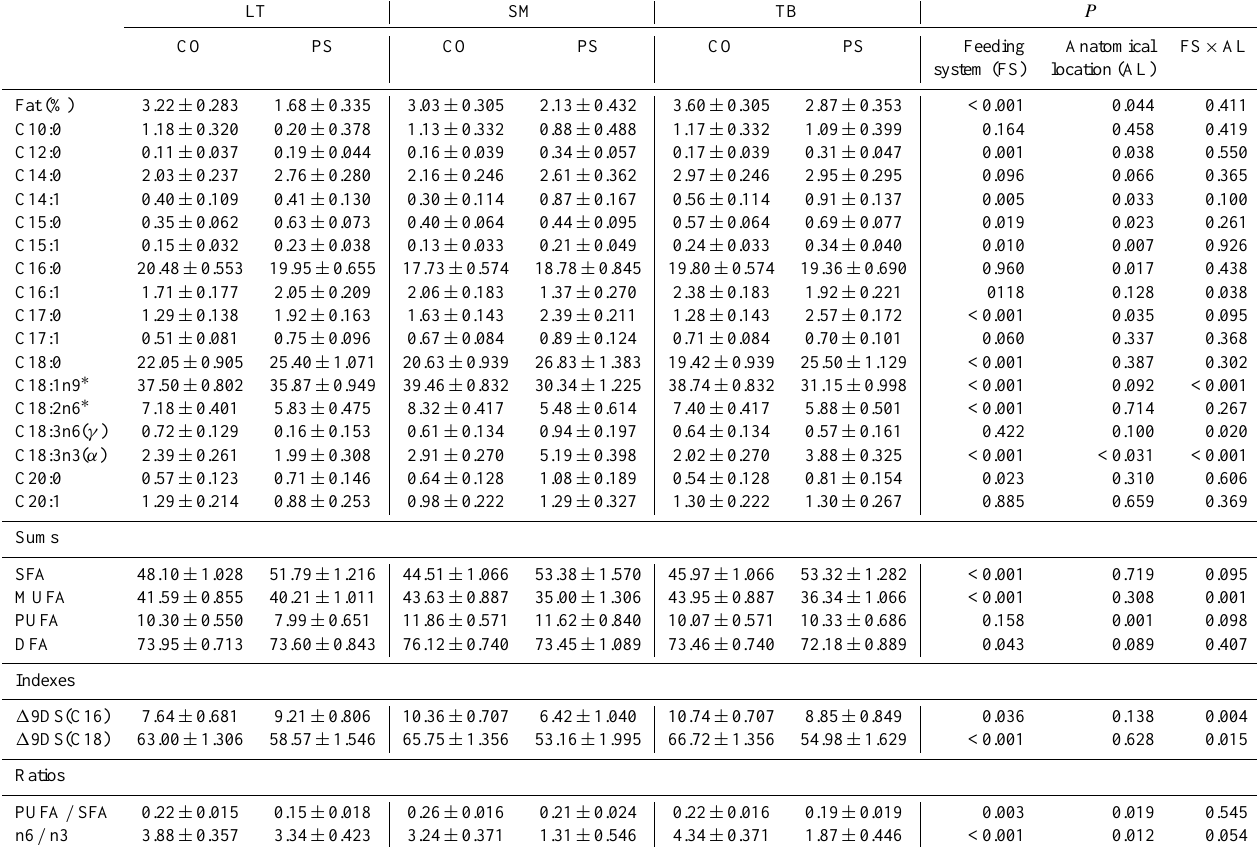
system (FS) location (AL)